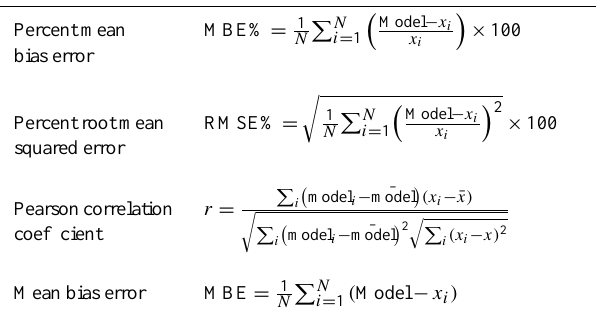
Table 3. Basic statistical quantities used for the assessment of the comparison of the BR model applied on the Mediterranean Sea, us- ing the two different in situ PSC classification approaches (Uitz et al., 2006, and Di Cicco, 2014, coefficients). N is the number of ob- servations and x is in situ